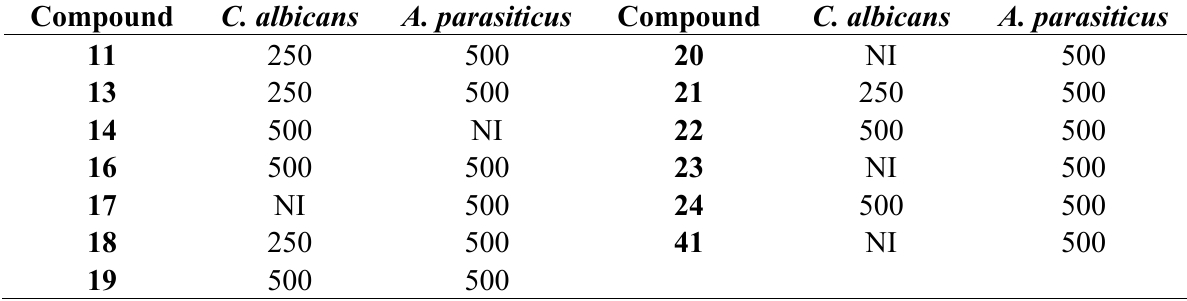
Table 3. MIC (  g/mL) values of thiosemicarbazones against C. albicans and A. parasiticus isolates.